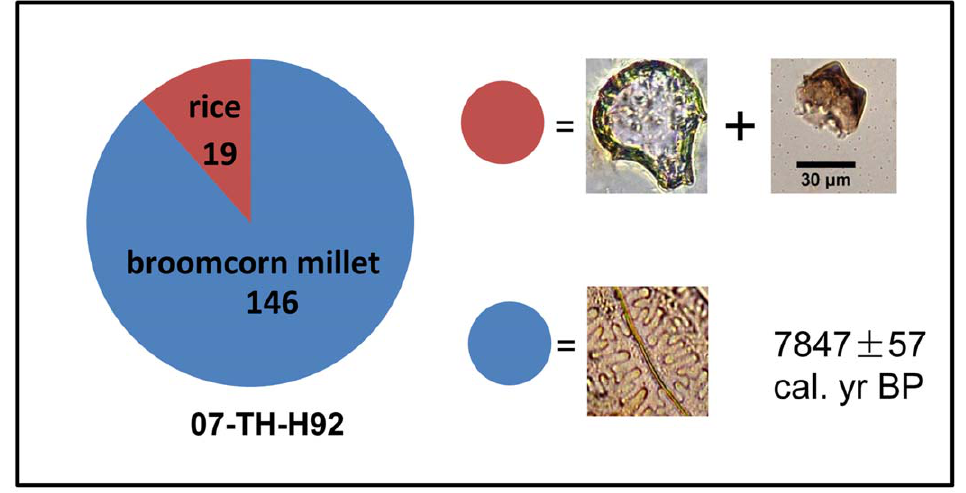
Figure 6. Ratio of phytolith from rice and broomcorn millet in H92 from the Tanghu site.